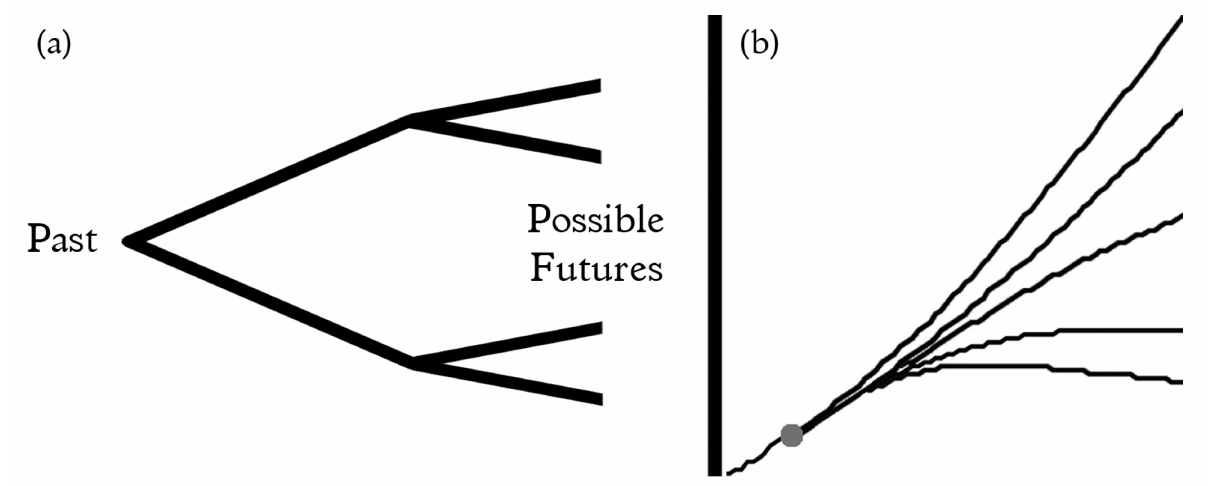
Figure 1. ( a ) Dupuy’s depiction of branching or occurring time. 2 ( b ) A recent IPCC chart showing possible paths of climate warming for the rest of the century, branching out from the present and spanning from about 1.5 ◦ C in the best case to nearly 5 ◦ C in the worst.